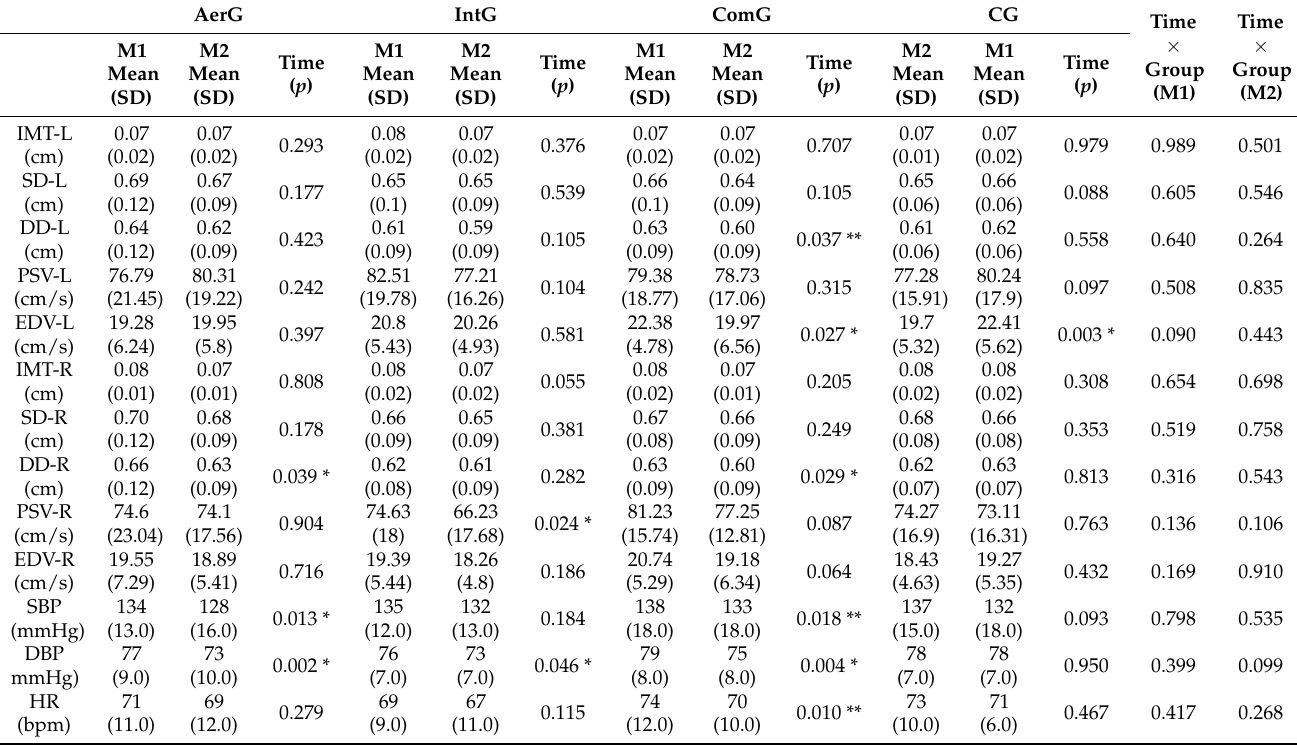
Table 2. IMT and Hemodynamic parameters